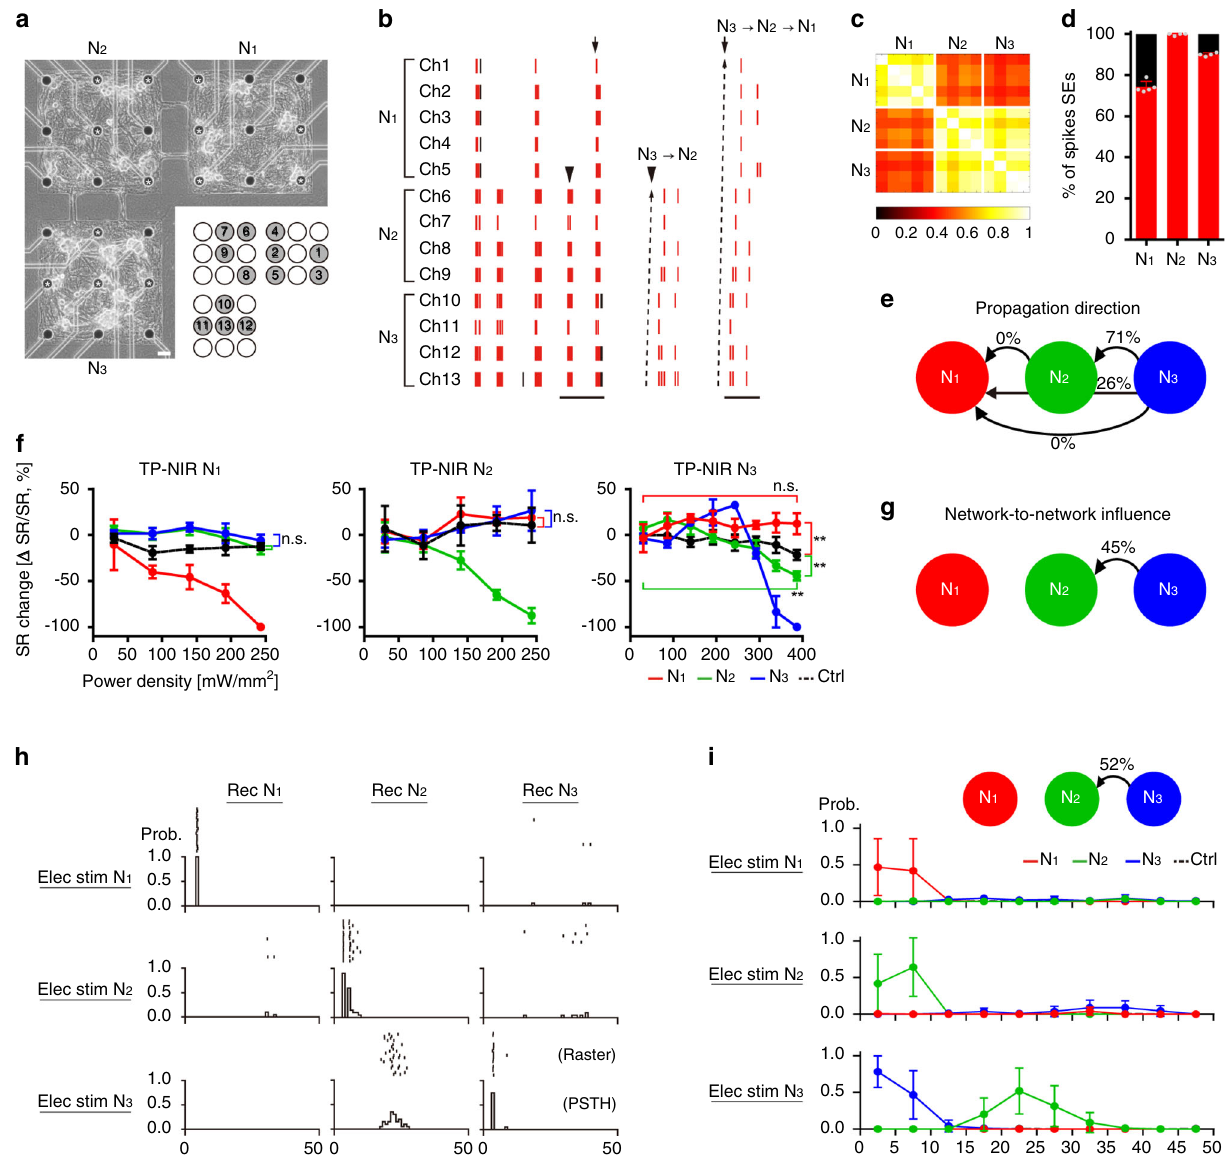
Fig. 6 Thermoplasmonic neuromodulation of a three-module network. a Phase-contrast image of tested network. Agarose micropatterns were 500 μ m by 500 μ m with a spacing of 100 μ m. The asterisks indicate recording electrodes and the corresponding numbers are marked on an MEA layout. Scale bar: 50 μ m. b Raster plots of spontaneous activity from 13 electrodes and examples of inter-network synchronized events (SEs) that spikes propagate from N 3 → N 2 (arrowhead) or from N 3 → N 2 → N 1 (arrow). Red timestamps represent spikes that participated in SEs. Scale bar: 10 s (left) and 200 ms (right). c Correlation matrix at 38 DIV. d Association degree in SEs. Red is the percentage of spikes participated in SEs. n = 5, 4, 4 electrodes for N 1 , N 2 , N 3 , respectively. Mean± SD. e Proportion of propagation direction within individual SEs. 552 detected SEs were analyzed. f Spike rate changes against power density for TP-NIR N 1 , TP-NIR N 2 , and TP-NIR N 3 . The black line (Ctrl) shows rate change in control groups (3 electrodes in unconnected networks) in the same MEA. n = 5 trials for each network. Mean± SD. Two-sided Mann – Whitney test (** p < 0.01); comparison with control groups at the highest power density: p = 0.8413, 0.0952 (N 2 , N 3 ) for TP-NIR N 1 ; p = 0.4206, 0.3095 (N 1 , N 3 ) for TP-NIR N 2 ; p = 0.0079, 0.0079 (N 1 , N 2 ) for TP-NIR N 3 ; comparison with the values at the lowest power density: p = 0.1508, 0.0079 (N 1 , N 2 ) for TP-NIR N 3 ; g Network-to-network in fl uence estimated by thermoplasmonic neuromodulation. h Representative PSTHs for electrical stimulation of a single electrode in each network. Bin size: 1 ms. i Mean PSTHs of all recording electrodes except stimulated ones. Stimulation electrodes: Ch3 and Ch5 in N 1 , Ch6 and Ch9 in N 2 , Ch12 and Ch13 in N 3 . 20 trials for each electrode. Bin size: 5 ms. n = 8, 8, 8 electrodes for Elec stim N 1 ; 10, 6, 8 electrodes for Elec stim N 2 ; 10, 8, 6 electrodes for Elec stim N 3 (N 1 , N 2 , N 3 , respectively); 10 electrodes for Ctrl. Mean ± SD. Source data are provided as a Source Data fi